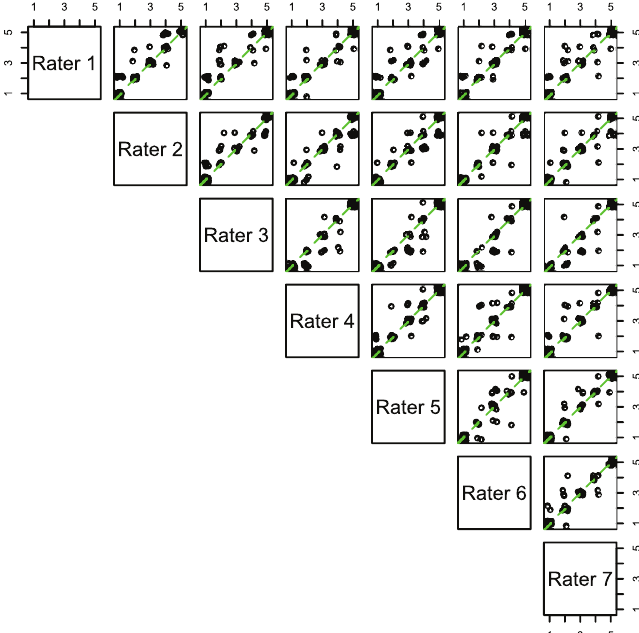
Fig 3. Head-to-head comparison of ratings from pairs of observers. Each of the 60 animal developmental stage ratings from a pair of reviewers is compared via the use of a pair-wise scatter plot matrix. The axis showing numbers 1 through 5 represents the animal stage with 1 representing L1, 2 representing L2, 3 representing dauer, 4 representing L3, and 5 representing L4. The green line represents perfect agreement between the two observers, and points along this line represent animals that are scored similarly by each observer. In contrast points either above or below the line represent disagreement between the raters. The ordinal values are slightly “ jittered ” to make it easier to discern the varying density of the